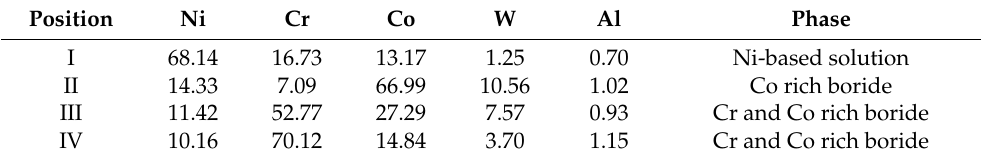
Figure 9. SEM images of fractured surface of TLP joints, with holding time ( a ) 5; ( b ) 30; ( c ) 60 and ( d ) 120 min. Table 4. EDS chemical analysis (at. %) of different positions in Figure 9.